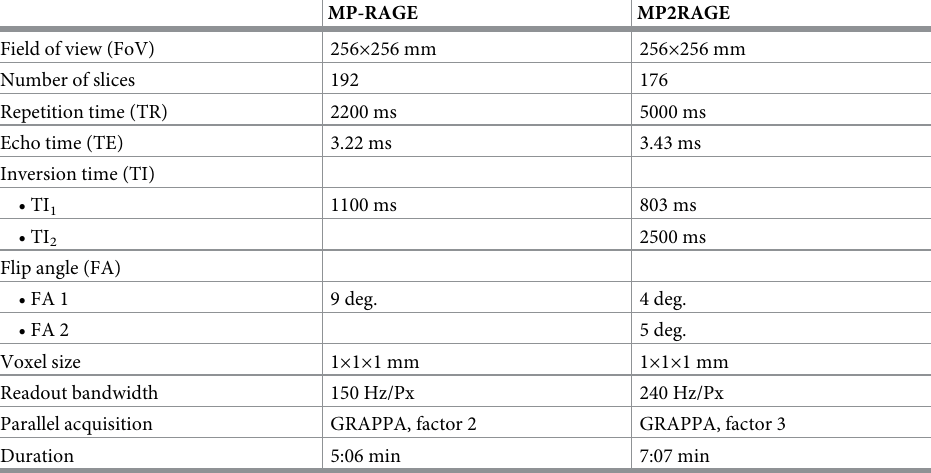
Table 1. Acquisition parameters of magnetization prepared- rapid acquisition gradient echo (MP-RAGE) and MP2RAGE